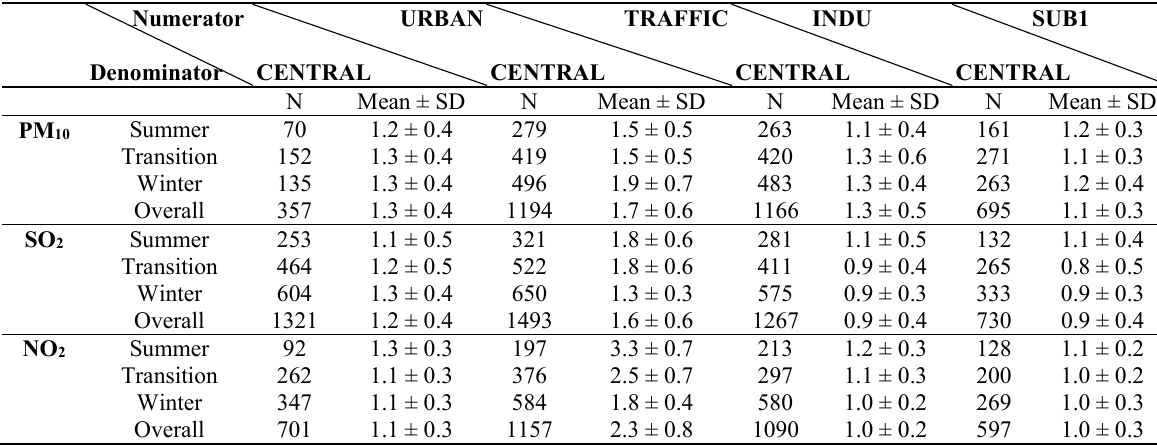
Table 5. Spatial concentration variability ratios using collocated monitors in 2000  2010 combined data. Denominator (reference) is set as the concentration of given pollutant at CENTRAL.